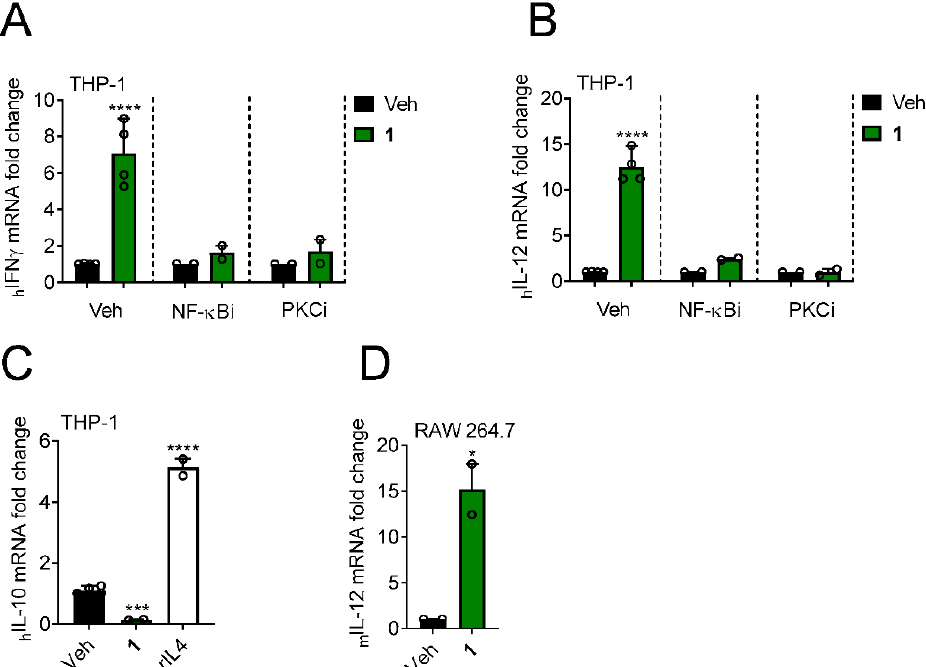
Figure 5. Yuanhuacine induces NF- κB dependent expression of antitumor cytokines. Expression of ( A ) IFNγ and ( B ) IL-12 mRNA in THP-1 cells pretreated with 1 μM of the indicated inhibitor or vehicle for 4 h and then treated with the 2 nM 1 or vehicle for 24 h. Significance determined by 2-way ANOVA with Šídák’s posthoc test. **** p < 0.0001. ( C ) Expression of IL-10 mRNA in THP-1 cells treated with 2 nM 1 or 1 μg/mL of recombinant human IL-4 for 24 h. ( D ) IL-12 mRNA expression in RAW 264.7 cells treated with 2 nM 1 for 24 h. Significance determined by unpaired t -test. * p < 0.05.